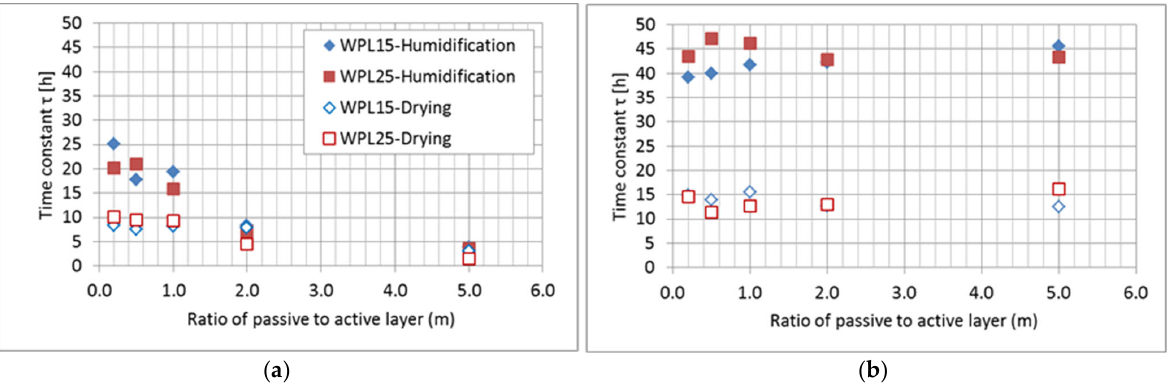
Figure 9. The rate of change of the deflection ( a ) and mass ( b ) of tested bimaterial actuators, determined by the time constant, in relation to the ratio of the thickness of the passive (PLA) to the active layer (WPL).